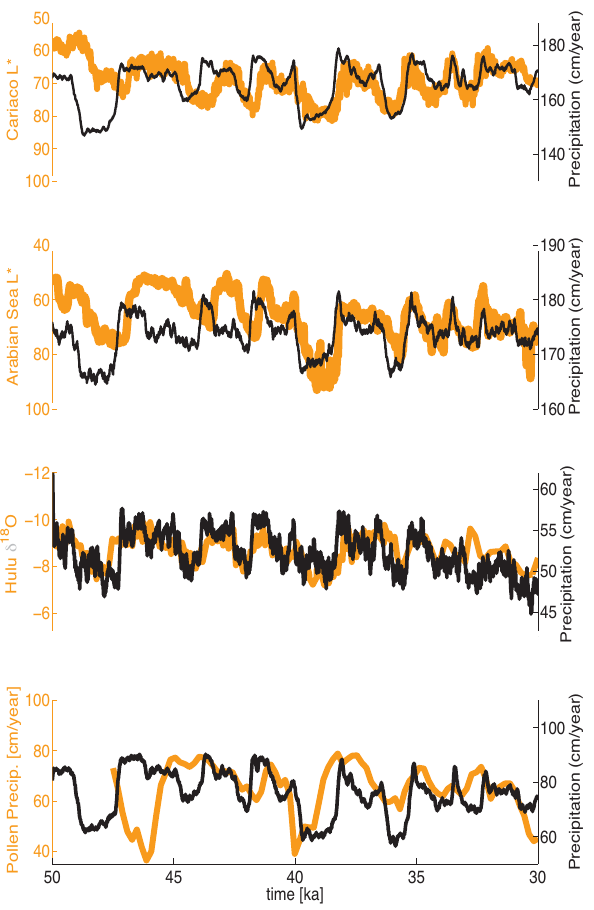
Fig. 5. From top to bottom: time series of simulated annual pre- cipitation anomalies over the Cariaco Basin (60–50 ◦ W, 5–20 ◦ N) compared to a reflectance record from the Cariaco Basin (Deplazes et al., 2013); time series of simulated Arabian Sea annual precipi- tation (45–65 ◦ E, 5–15 ◦ N) compared to a reflectance record ( L ∗ ) from the northeastern Arabian Sea (Deplazes et al., 2013); simu- lated precipitation in eastern China (114–124 ◦ E, 28–35 ◦ N) com- pared to a speleothem δ 18 O record (‰) from Hulu Cave, China (Wang et al., 2001); time series of simulated Iberian region an- nual precipitation (10–1 ◦ W, 35–40 ◦ N) compared to a composite of pollen-derived precipitation estimates from the Iberian margin and the Alboran Sea (Sánchez-Goñi et al., 2002); Model results are in black and paleoproxy records in orange.